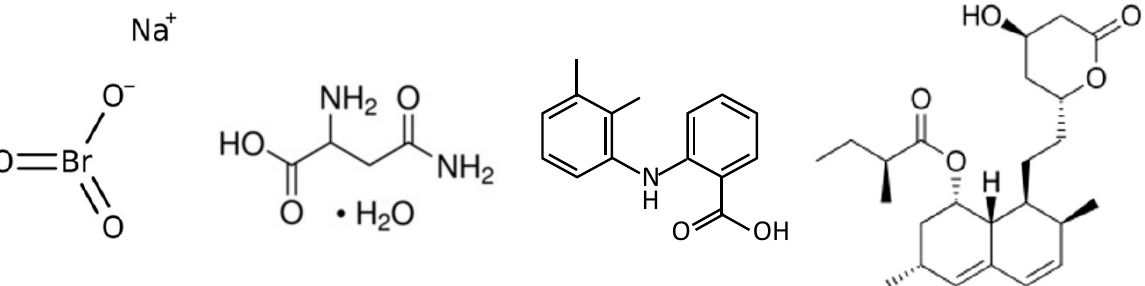
Figure 2. Molecular and ionic structure of the four model compounds. From left to right: Sodium Bromate (NaBrO 3 ), DL-Asparagine Monohydrate (ASN), Mefenamic Acid (MFA) and Lovastatin (LOV).